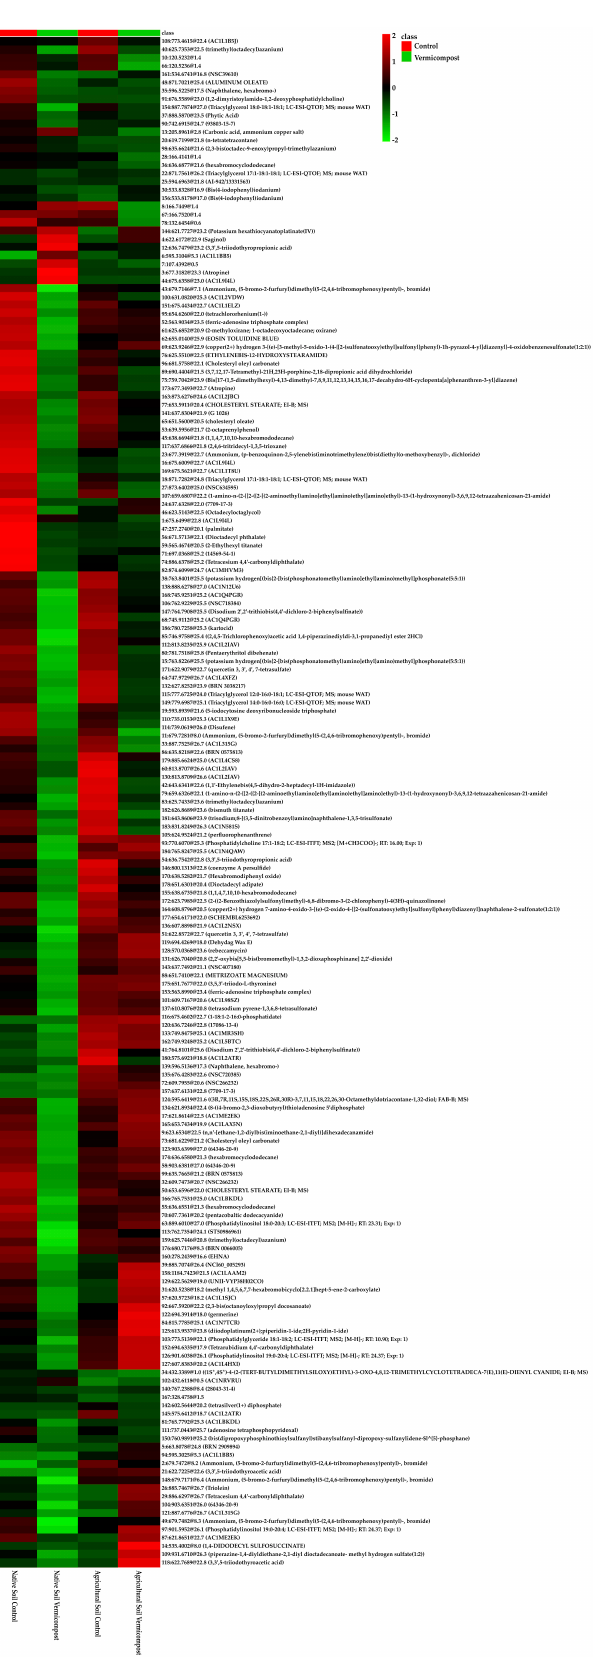
Figure 6. Heat maps corresponding to Moringa oleifera leaves’ extracts cultivated with vermicompost over agricultural and native